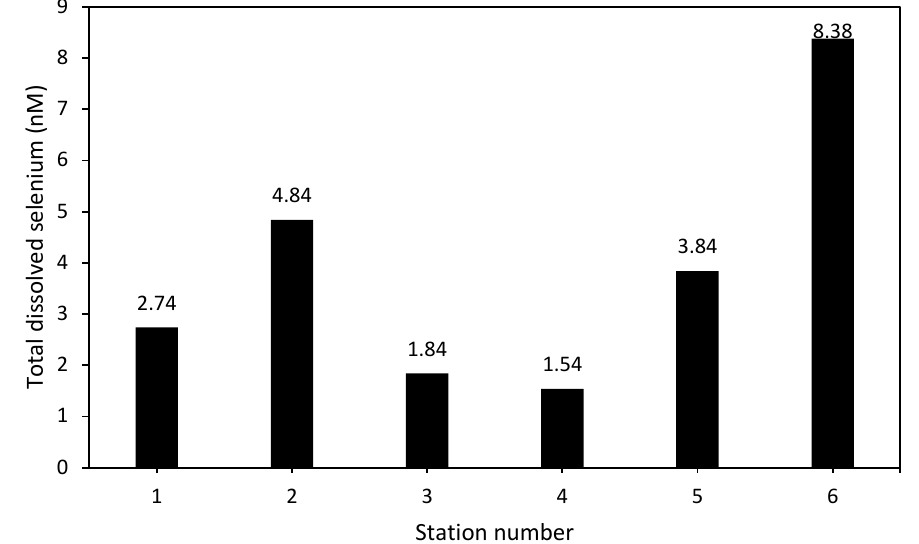
Figure 7. Distribution of the total dissolved selenium in the surface water of the Sharm Obhur.